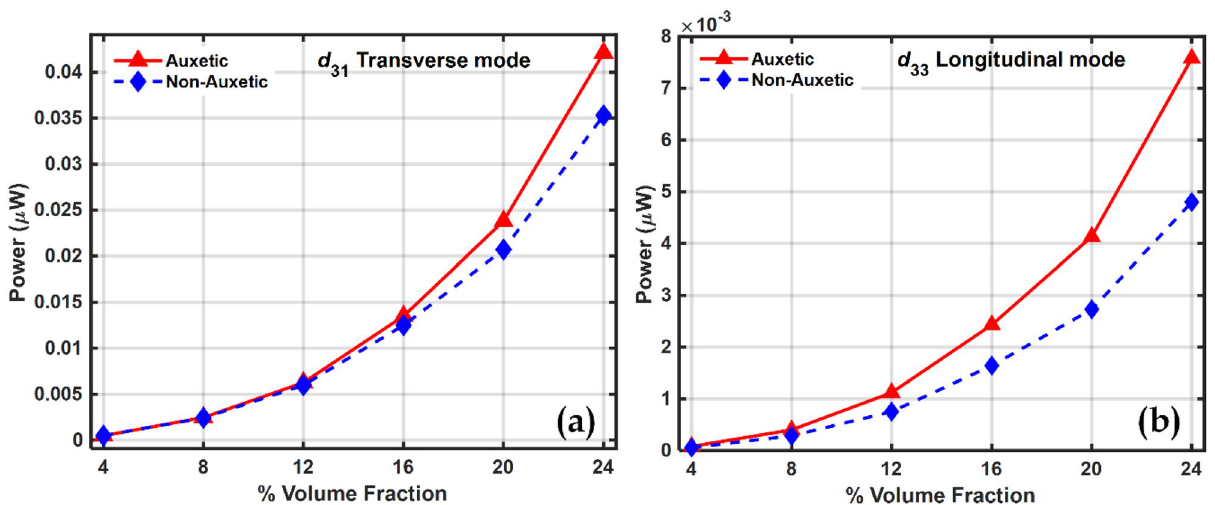
Figure 12. Maximum power vs volume fraction of BCZT auxetic and non-auxetic piezocomposite in ( a ) Transverse mode ( b ) Longitudinal